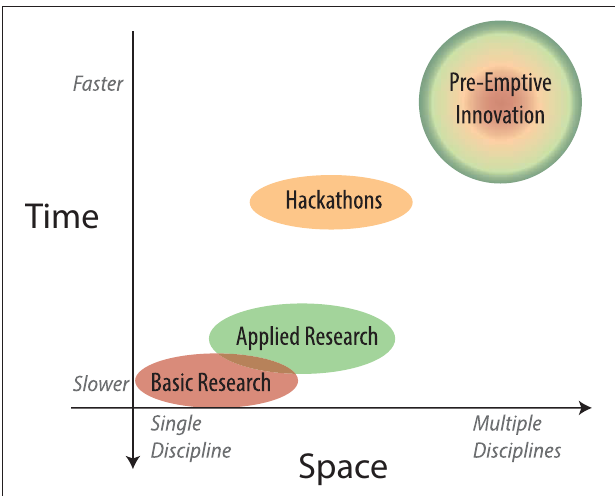
FIGURE 1 | Comparison of various innovation processes along spatial and temporal